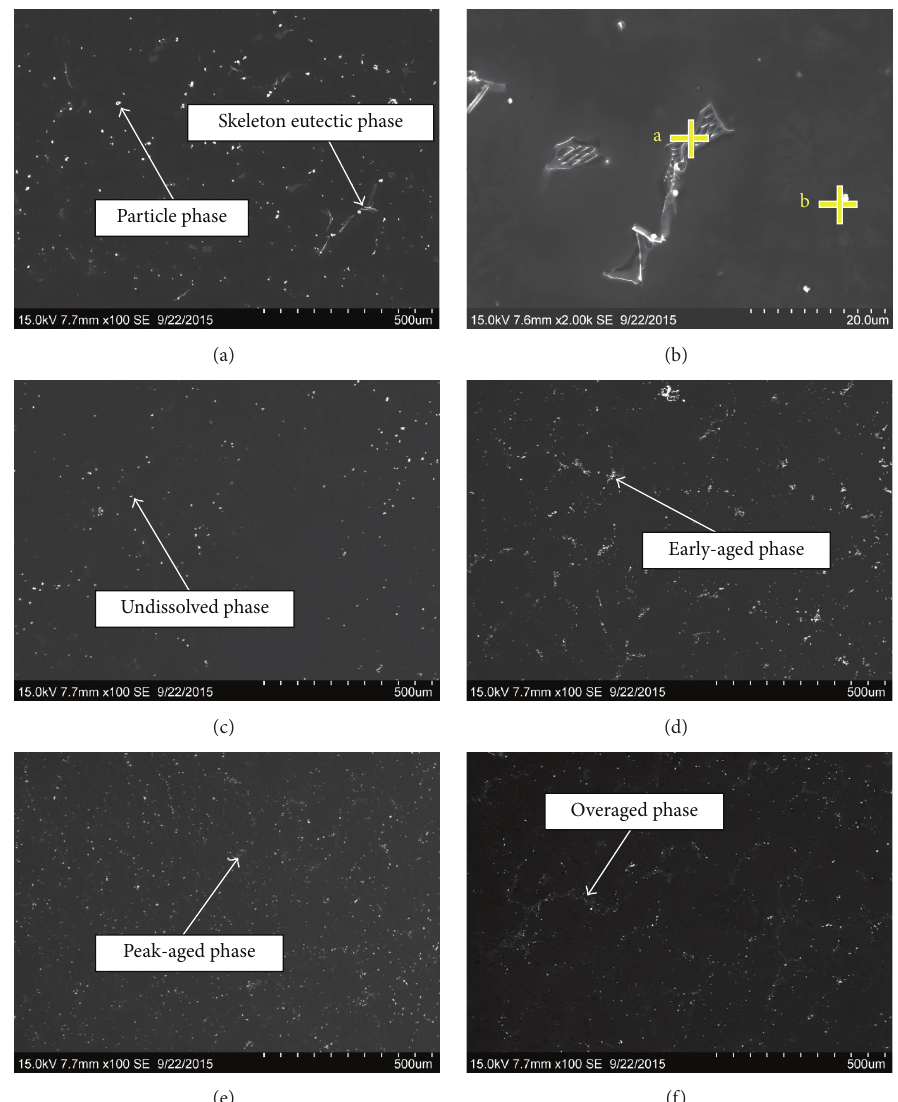
Figure 1: The SEM photographs of Mg-5Y-1.5Nd alloys: (a) as-cast, (b) close-up view of (a), (c) T4, (d) T6-6h, (e) T6-14h, and (f) T6-24h.